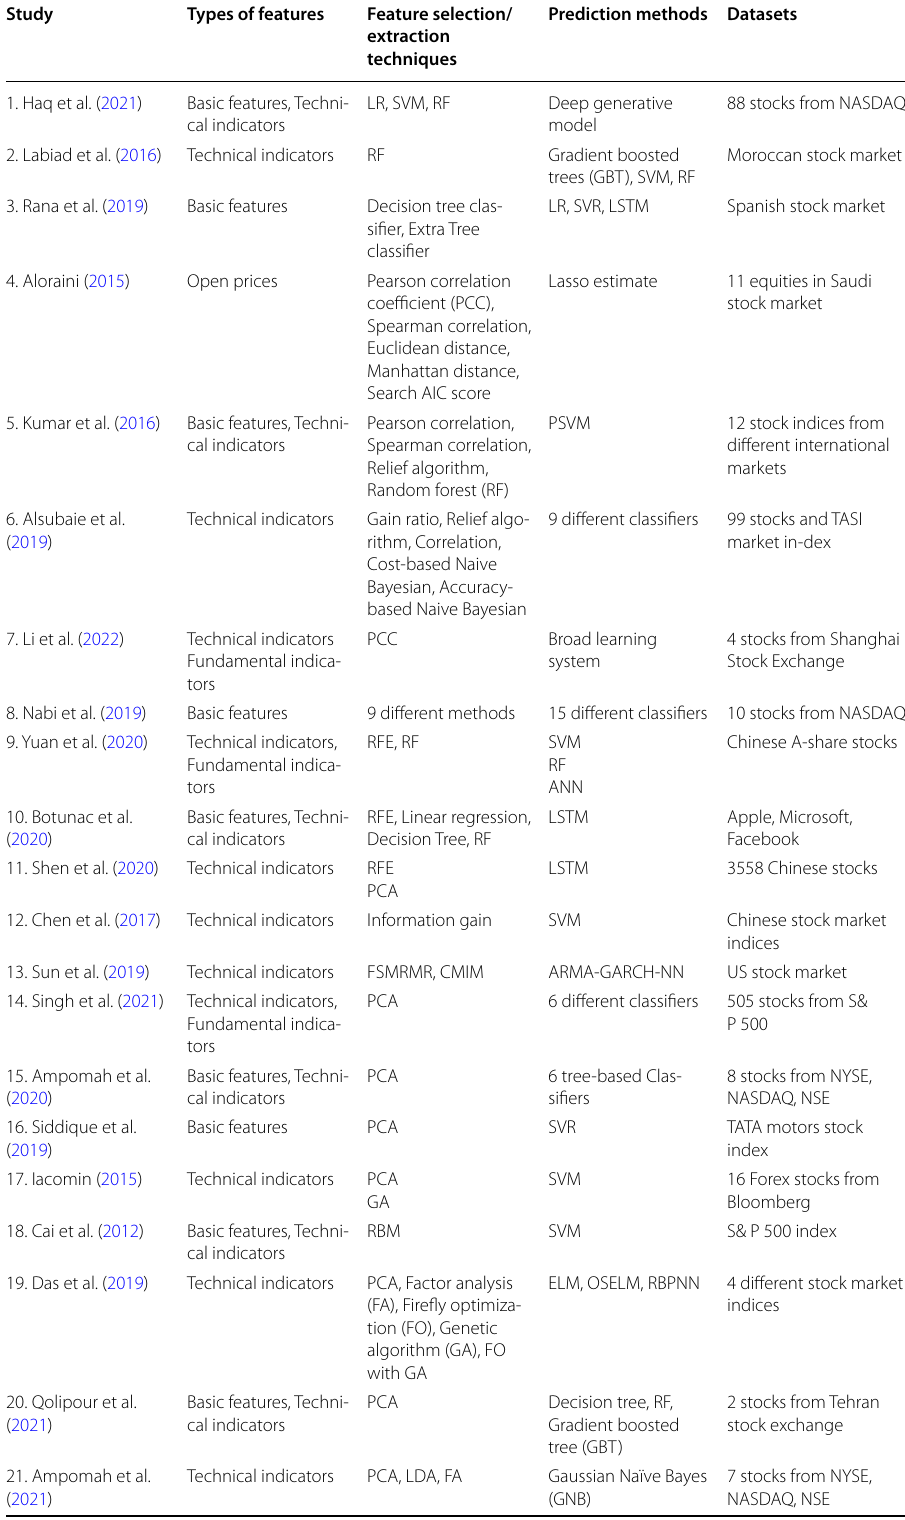
Table 1 Analysis based on types of features, feature selection/extraction techniques, predictive models, and